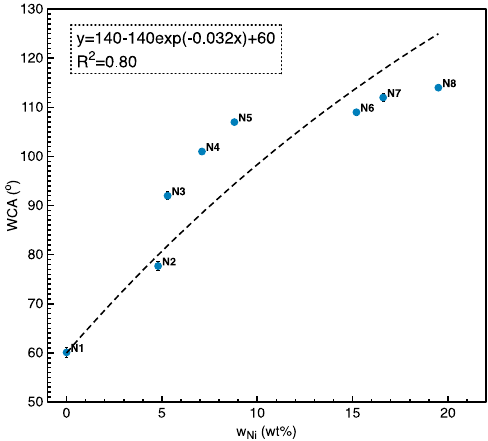
Figure 12. Relationship between WCA of Cu/Ni-coated fabrics and w Ni .